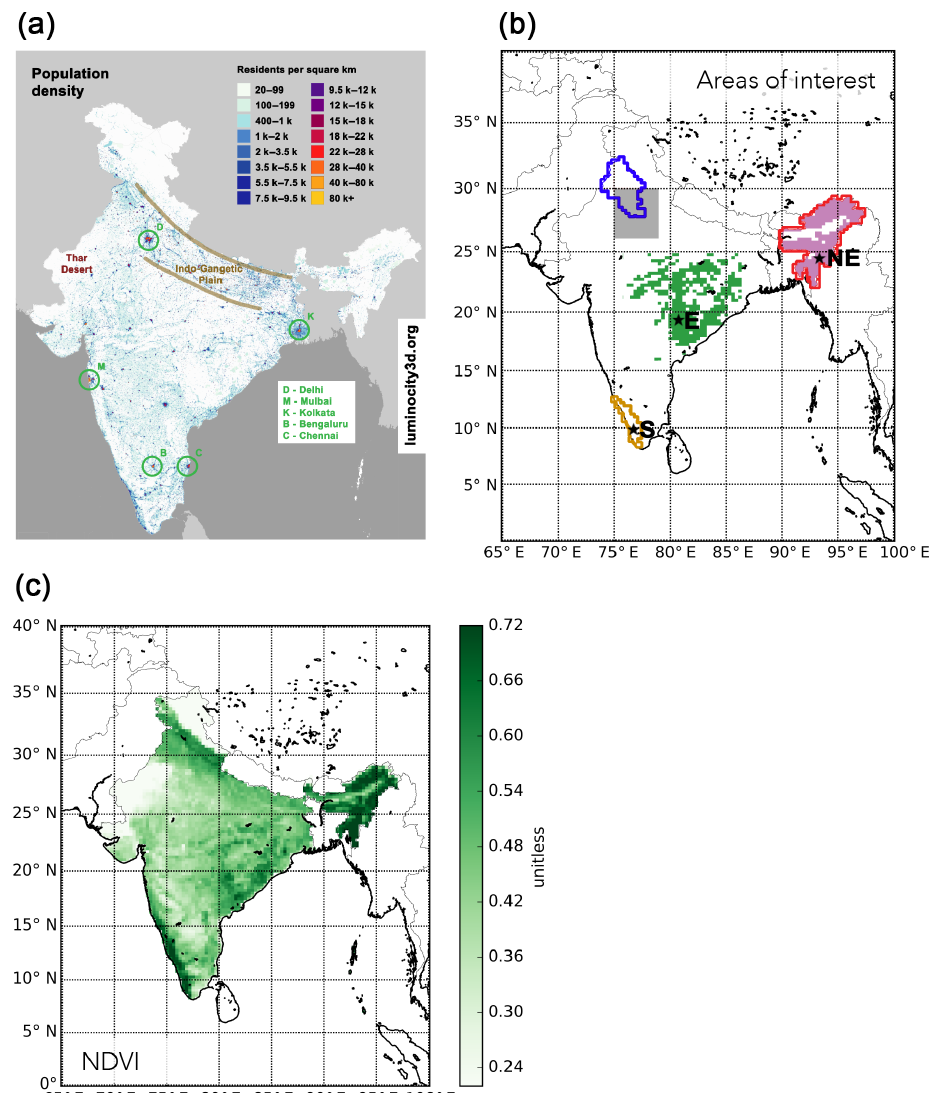
Figure 1. Geography of India: population density based on the 2001 census (a) ; focal points of this study (b) ; and annual mean values of the Normalized Difference Vegetation Index (NDVI) for 2014 from the NASA MODIS instrument, averaged on the 0 . 25 ◦ × 0 . 3125 ◦ GEOS- Chem nested grid (c) . For the map of focal points (b) : the blue outline represent the states of Punjab and Haryana; the red outline denotes the “Seven Sister States”; and the yellow outline represents the state of Kerala. The pink and green shaded areas denote the NE and E forest sites, where we infer isoprene emissions from OMI HCHO columns. The grey shaded area denotes the oversampling region used to study Delhi. The stars denote the sites where we study HCHO production using a 0-D photochemical model. The population image is modified with permission from http://luminocity3d.org/: data provided by EC JRC & CIESIN, and the design provided by Duncan Smith, Bartlett Centre for Advanced Spatial Analysis, University College